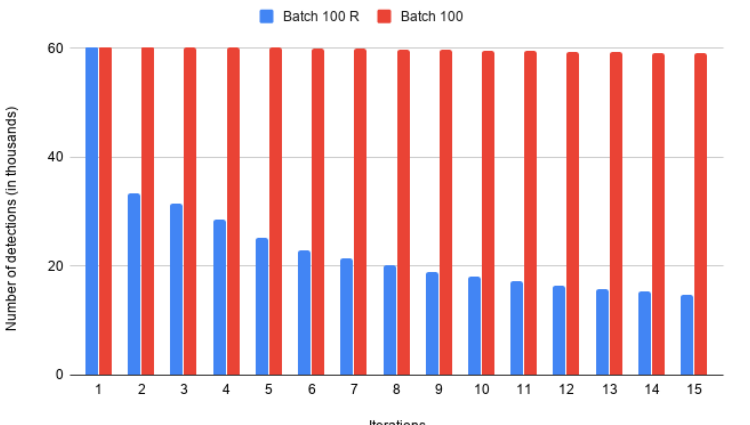
Figure 6. AP for network trained with batch 100 and network trained with modified algorithm with non-informative samples removed.